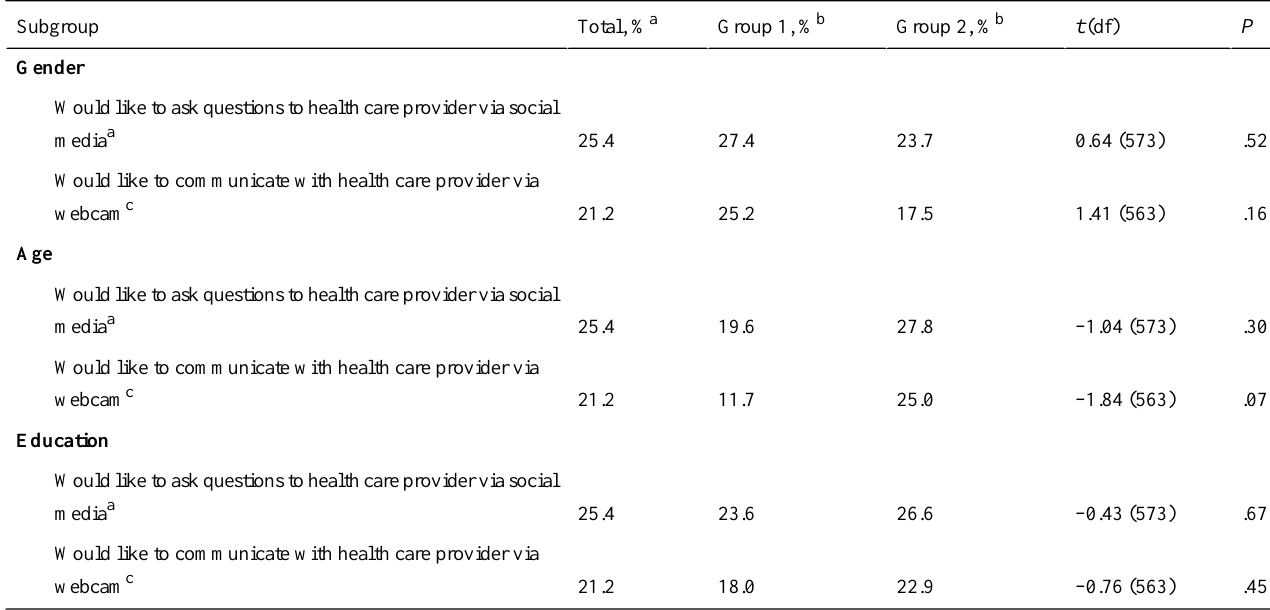
Table 6. Preferences for communication in health